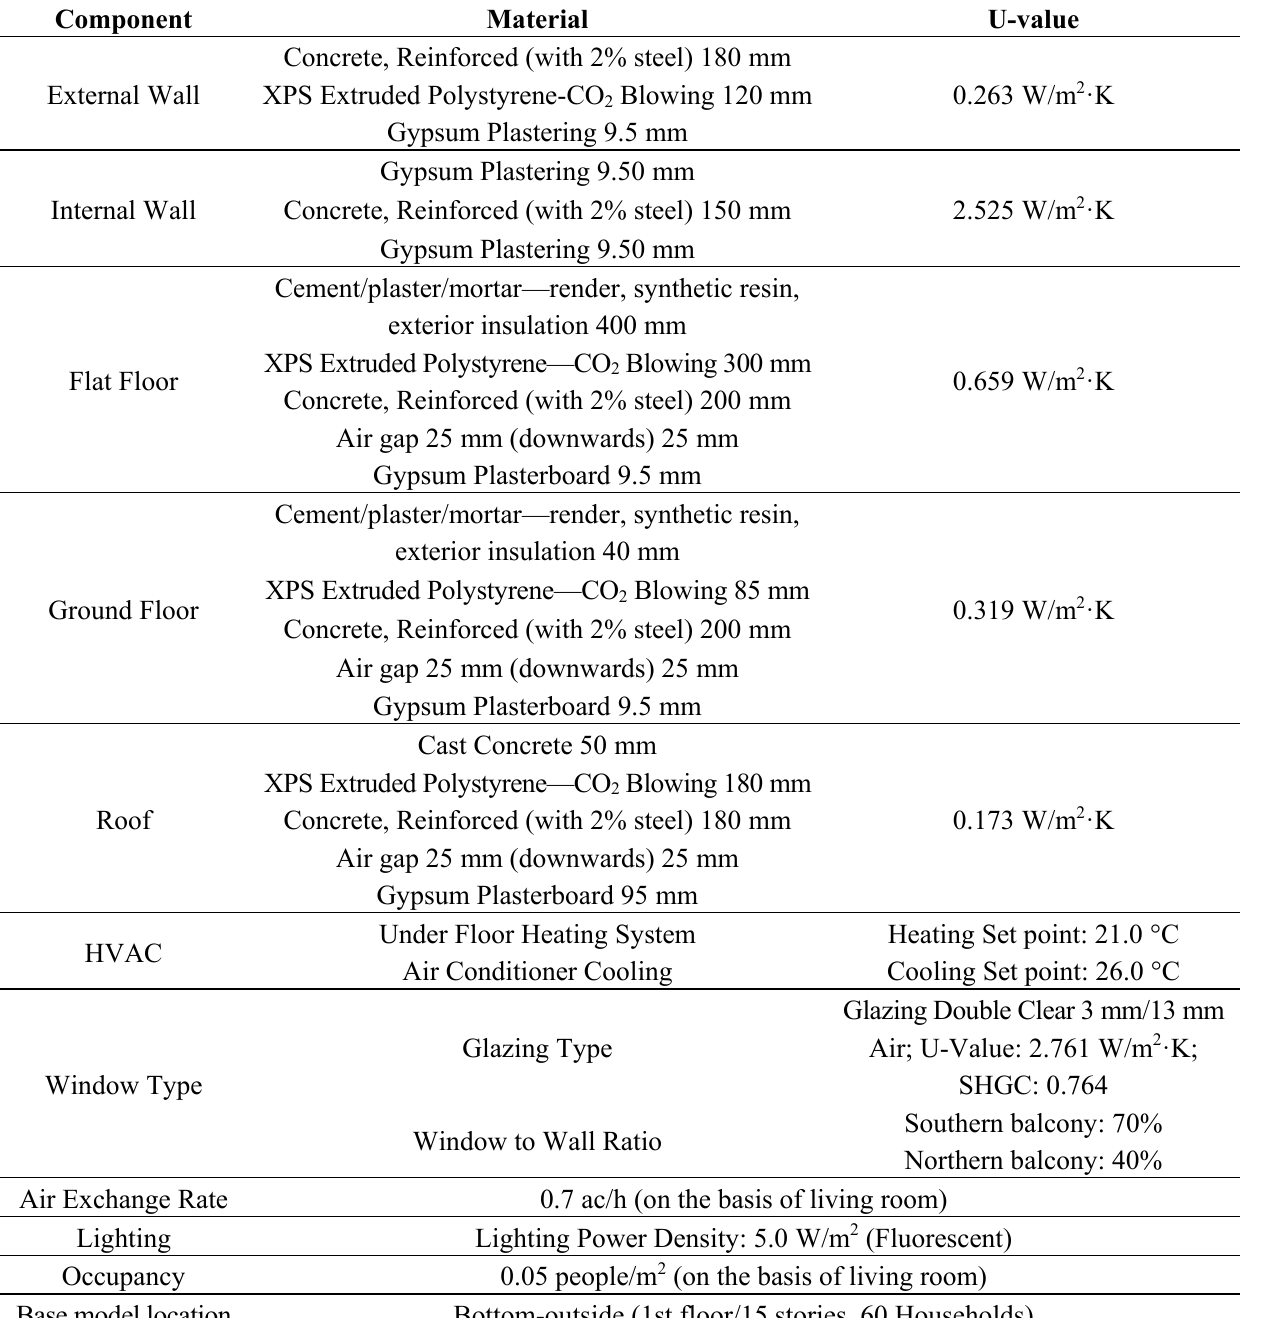
Table 2. Standard condition for the simulation